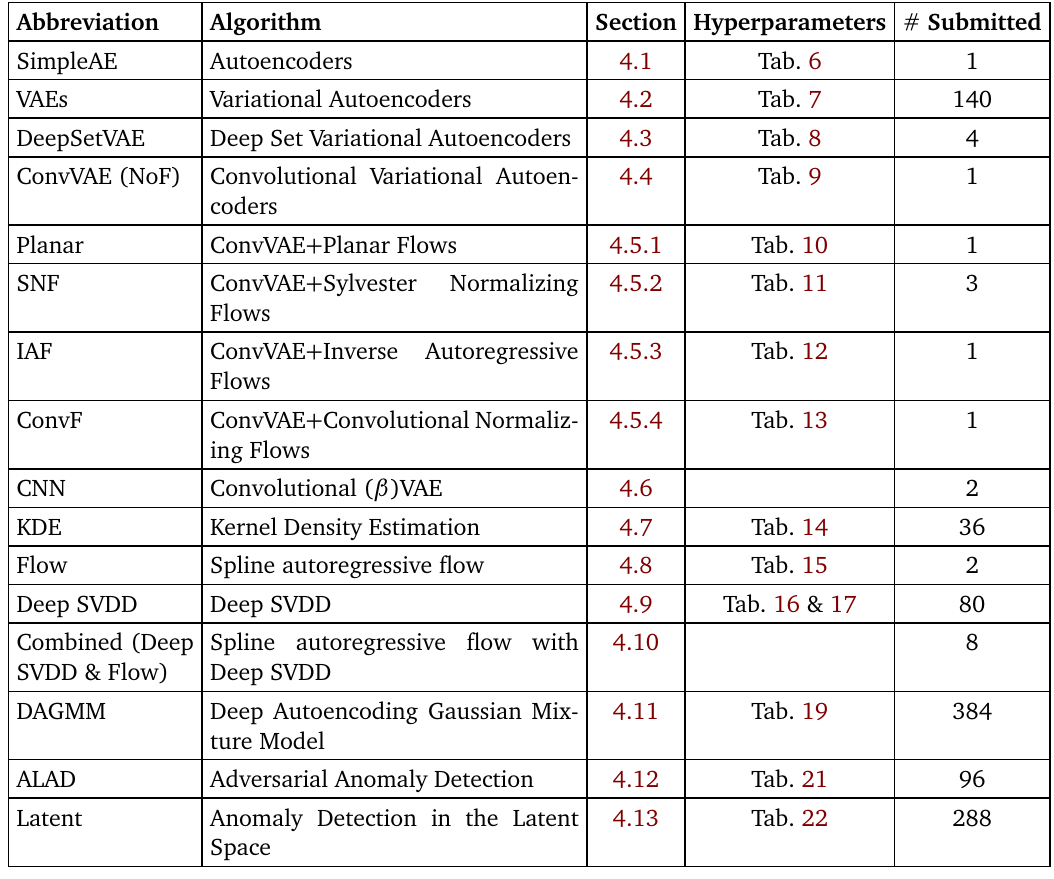
Table 5: Summary of the